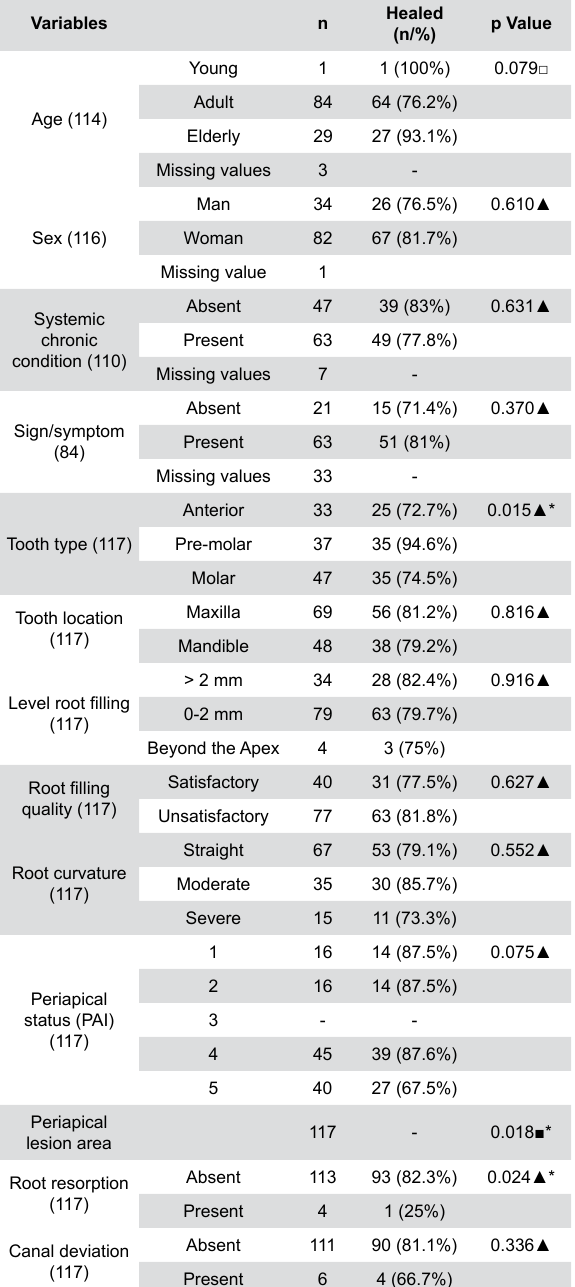
Table 4- Prognostic factors associated with periapical healing in endodontic retreatment (N = 117)